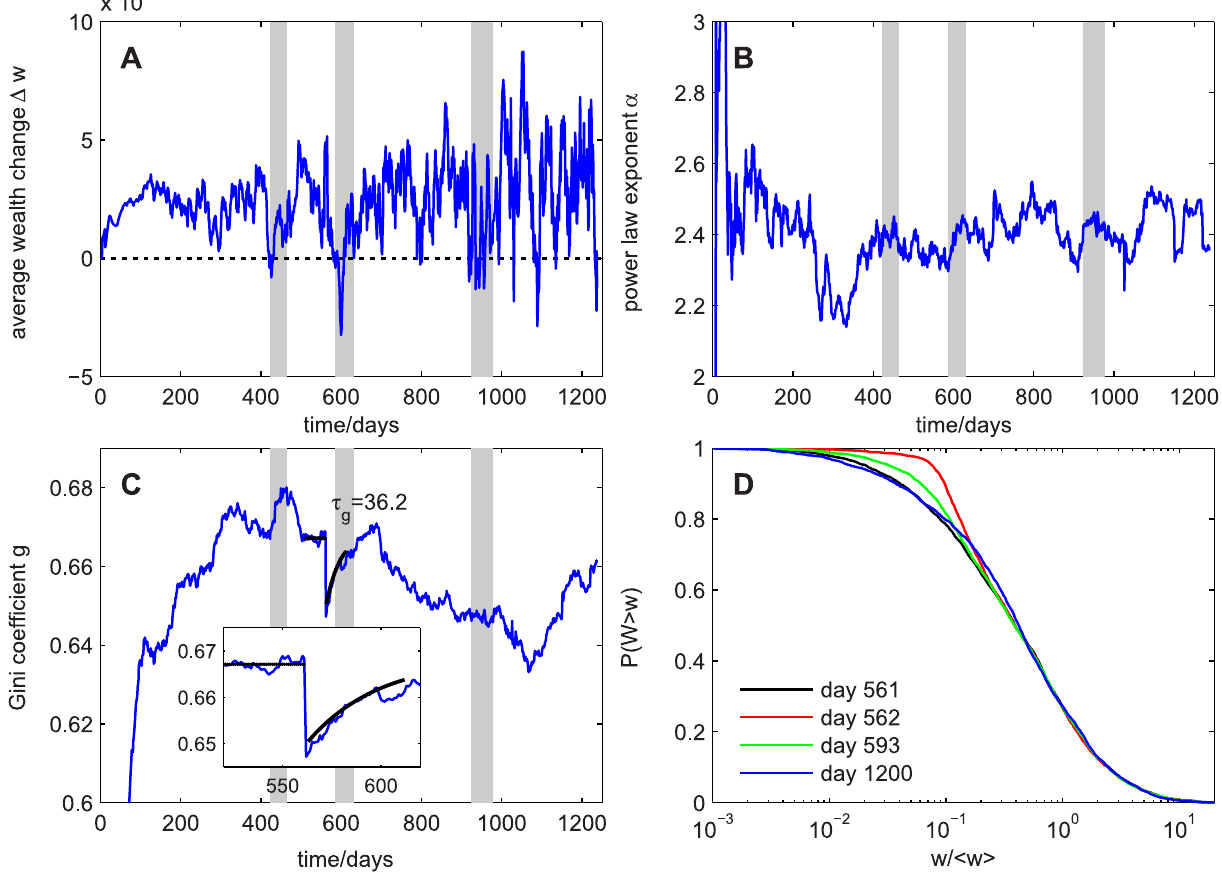
Figure 2. Time evolution of the wealth distribution in the entire society. A Seven day moving average of the change of the average wealth D w ( t ) . B Power-law exponent a ( t ) , C Gini index g ( t ) . D Scaled wealth distribution at four different days (rescaled by average wealth). Gray shaded areas indicate periods of large scale war in the game. A ‘‘Christmas charity’’ event on day 562 led to a re-distribution from the wealthy to the poor, resulting in a downward jump of the Gini index. The inset shows the exponential recovery to the previous level.